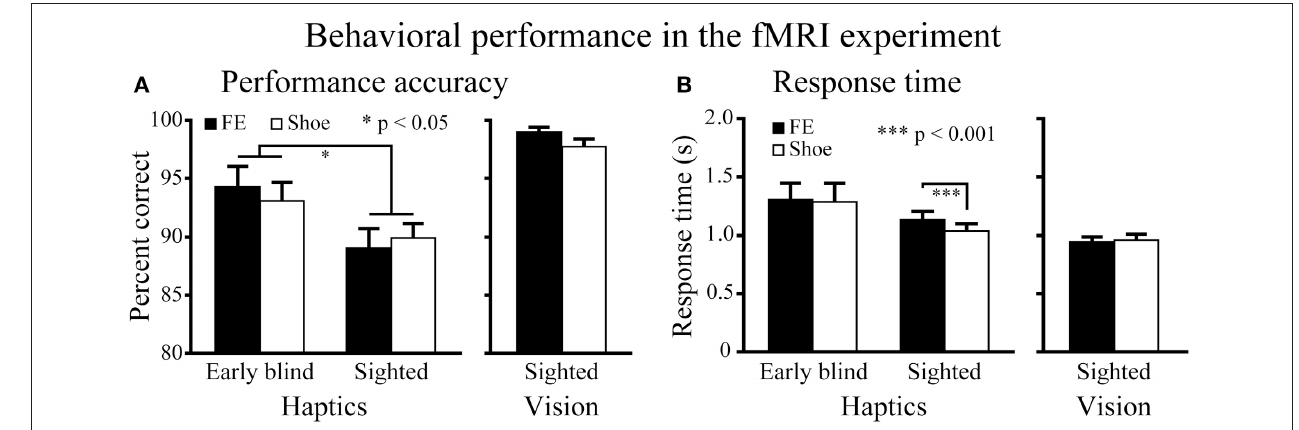
FIGURE 4 | Behavioral results for the fMRI experiment. (A) Performance accuracy. Asterisks between the two groups indicate a significant main effect of group (ANOVA). (B) Response time. Asterisks between the conditions